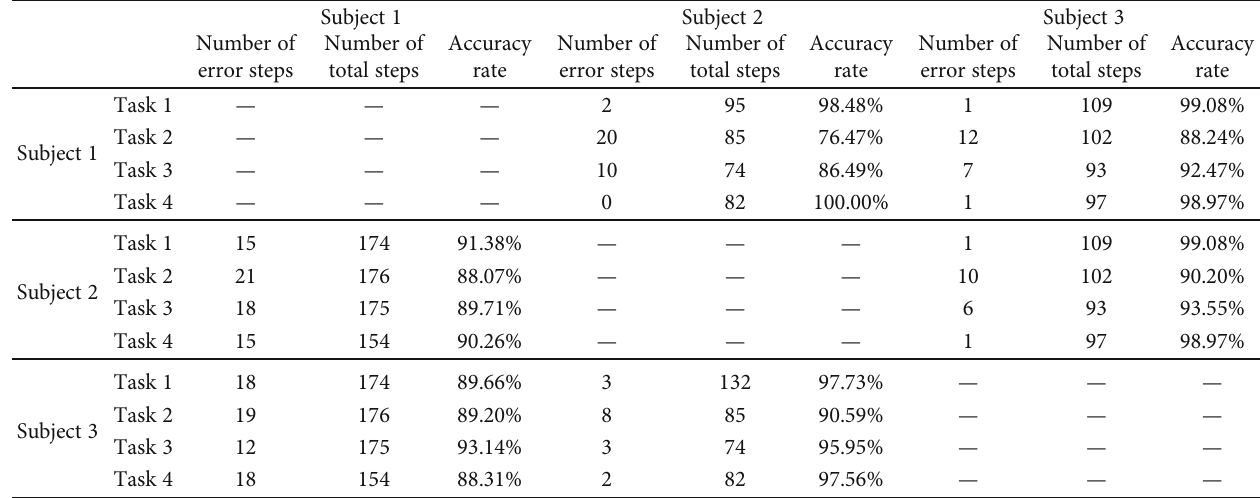
Table 4: Recognition accuracy of 1 :2 intersubject validation.